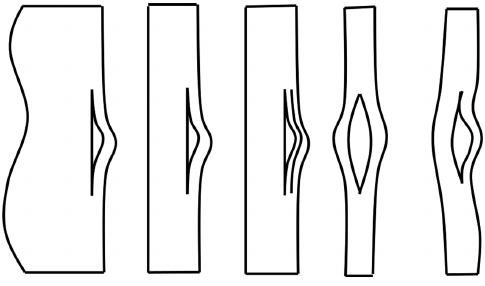
Figure 2 Possible delamination buckling